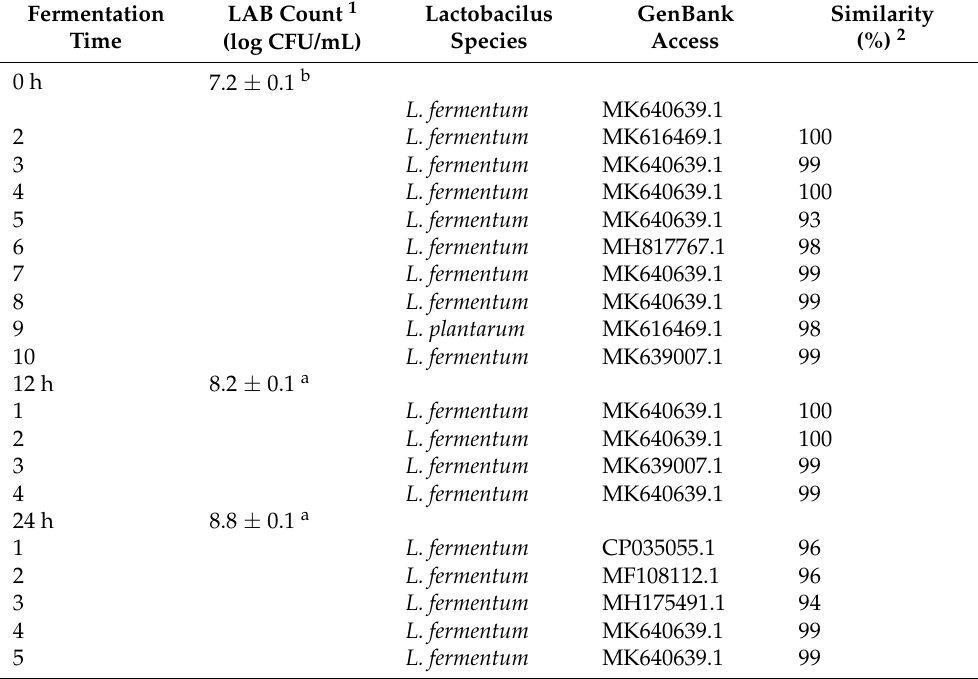
Table 1. Molecular identification of lactic acid bacteria isolated during the spontaneous fermentation of manipueira for tucupi